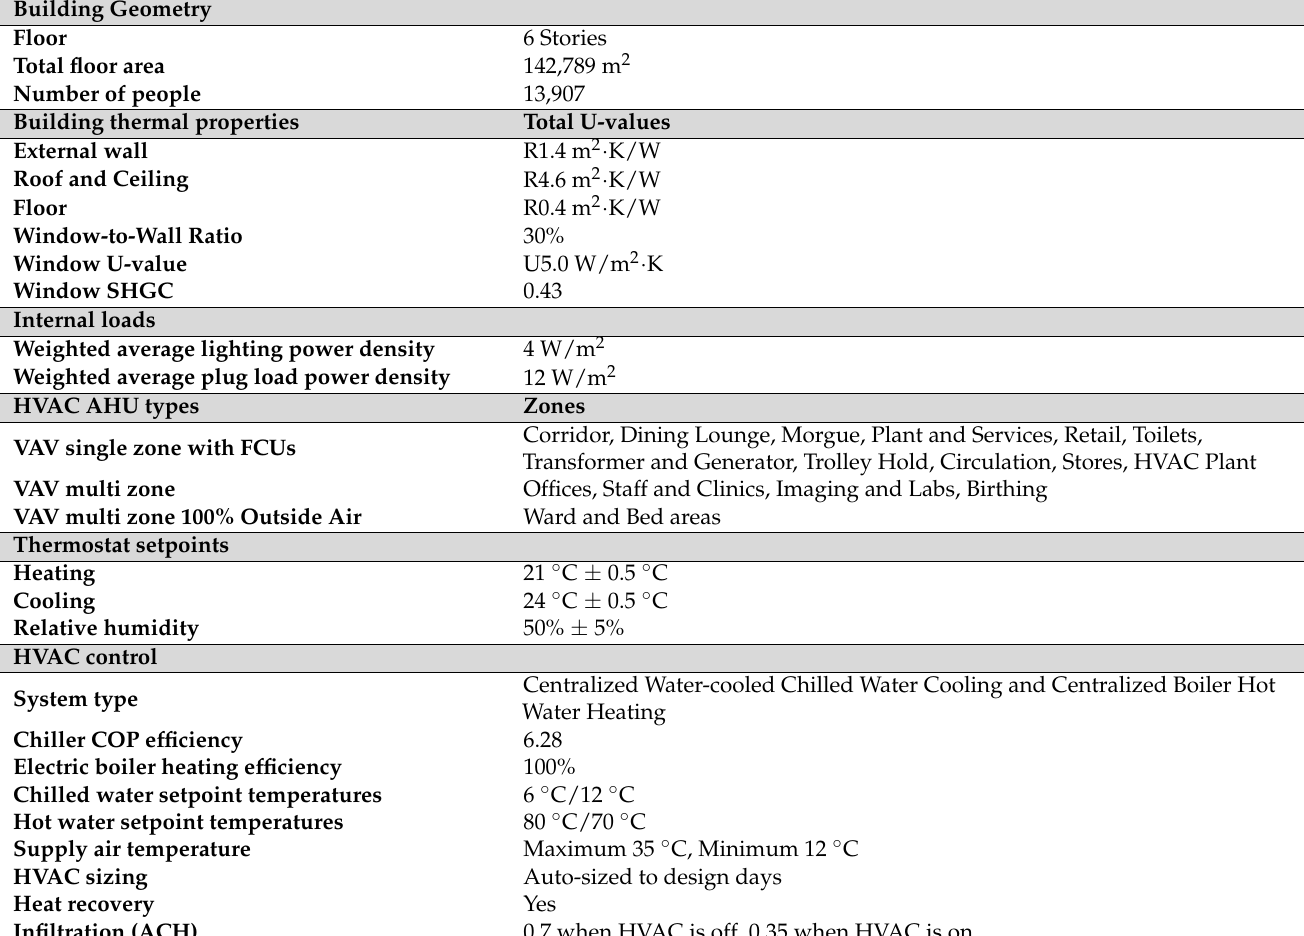
Table 7. Large hospital model specification